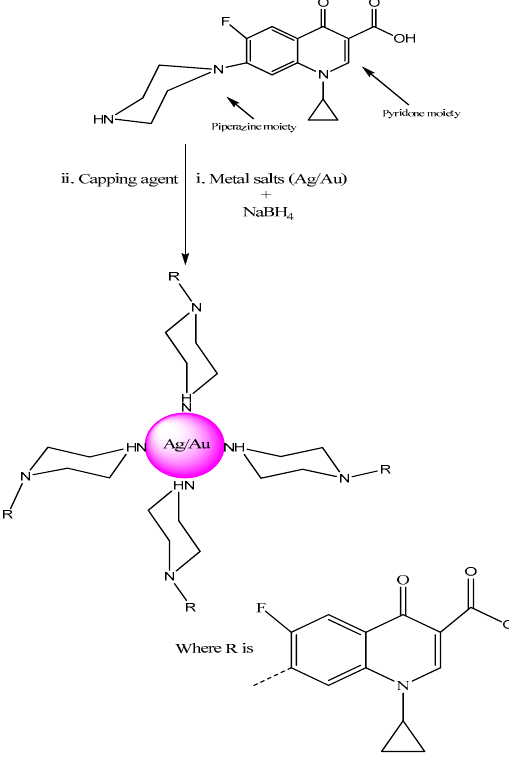
Figure 1. Stabilizing and capping action of ciprofloxacin with noble metals (Ag/Au).